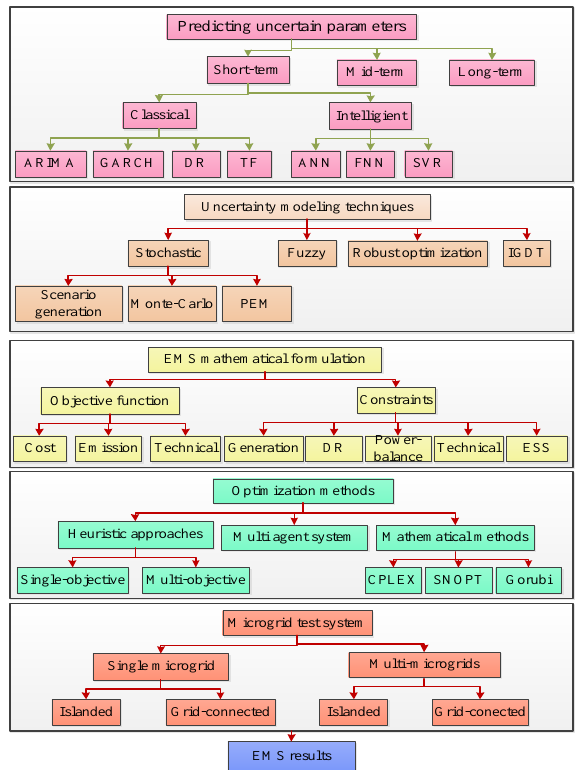
Figure 2. Overall EMS structure and underlying methods of each step.